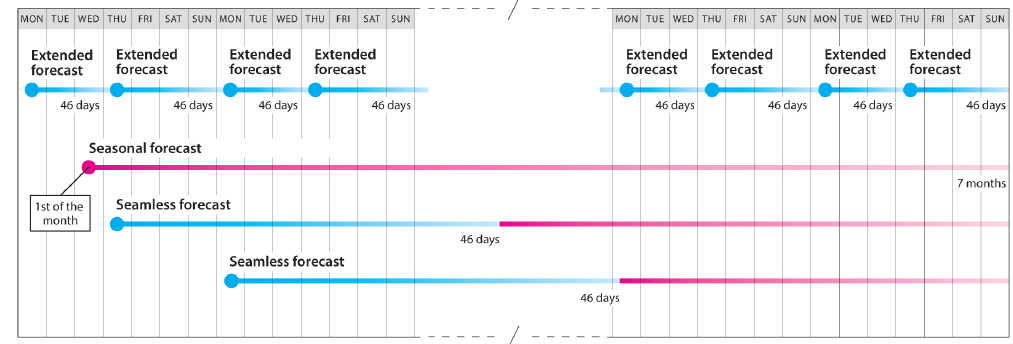
Figure 2. Schematic overview of the seasonal, extended-range forecast and merged systems. The extended forecast is issued every Monday and Thursday and extends up until 46 days, the seasonal forecast is issued on the first of each month and extends up until 7 months (13 months in February, May, August and November). The merged forecast concatenates the latest extended forecast with the latest seasonal